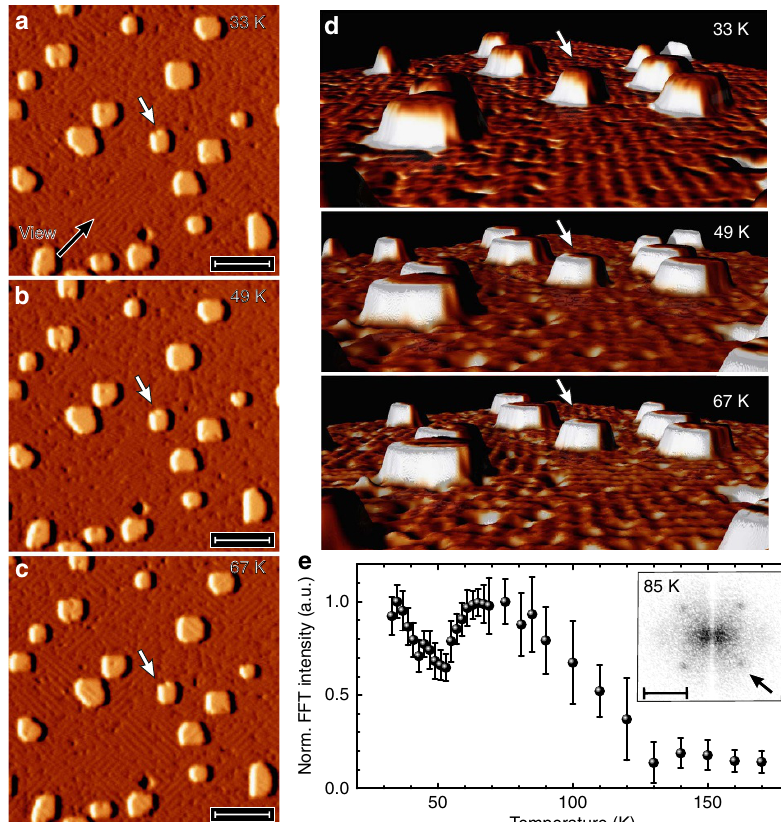
Figure 3 | Temperature-dependent charge ordering. ( a – c ) STM topographic showing the very same location of the sample surface at T ¼ 33, 49 and 67K. Scale bars, 20nm. One island is marked by white arrows. ( d ) Rendered perspective images as seen along the viewing direction marked by a black arrow in a . Although the stripes are clearly visible at low and high temperatures (see, for example, the area in front of the island marked by a white arrow), the intensity is strongly reduced at the intermediate temperature. ( e ) Plot of the temperature-dependent normalized intensity of the spots indicative for the stripe pattern (see arrow). A dip starting at around T ¼ 70K can be recognized. An example of a Fourier-transformed STM image taken at T ¼ 85K is shown in the inset. Error bars represent the spot’s full width at half maximum after subtraction of the background intensity. Scale bar, 1nm (cid:3) 1